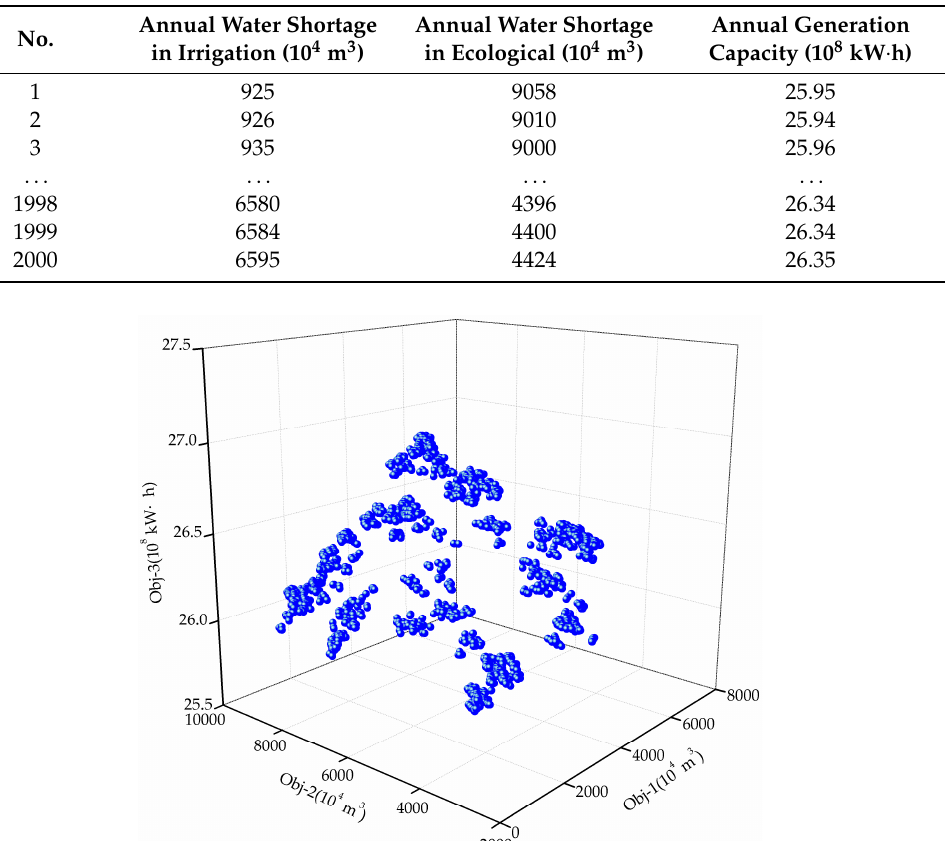
Figure 3. Multi-objective Pareto surface graph of Obj 1~3 in one coordinate system. Blue points indicates non-inferior solution.